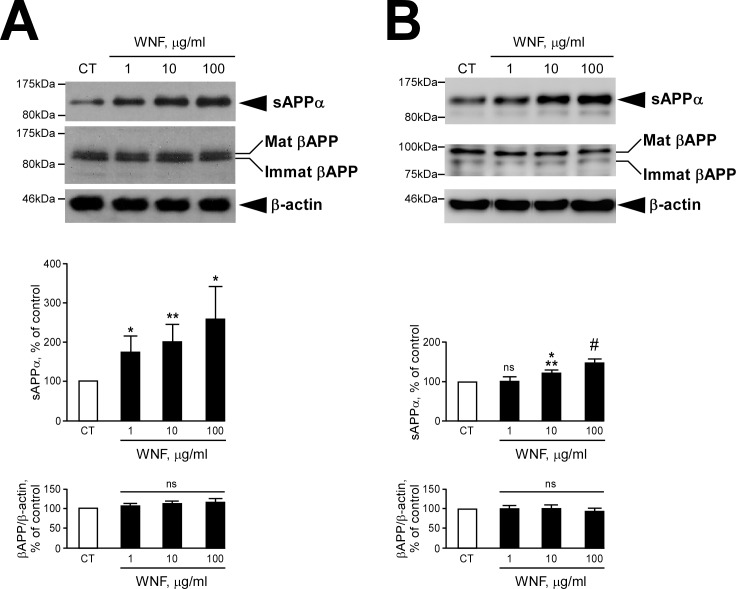
WNF promotes sAPPα production in mouse and human neuroblastoma cell lines.Cultured βAPP695-N2a mouse cells (A) or wild-type SH-SY5Y human cells (B) were incubated without (control) or with the indicated concentrations of WNF (in 1ml DMEM/1% FBS) for 16 hours at 37°C. After secretion for 1 hour (A) or 3 hours (B) (in 1ml serum-free DMEM), media and cell lysates were collected and sAPPα, βAPP and β-actin were analyzed by Western blot. Immunoblots illustrate representative gels and histograms correspond to the statistical analysis for all experiments. All bars correspond to the densitometry analyses (βAPP being normalized with β-actin), are expressed as a percentage of control (white bars, non treated cells) taken as 100 and are the means ± SE of 8 (A) or 6 (B) independent experiments. *p<0.05; **p<0.02; ***p<0.002; #p<0.0001; ns, non-statistically different.